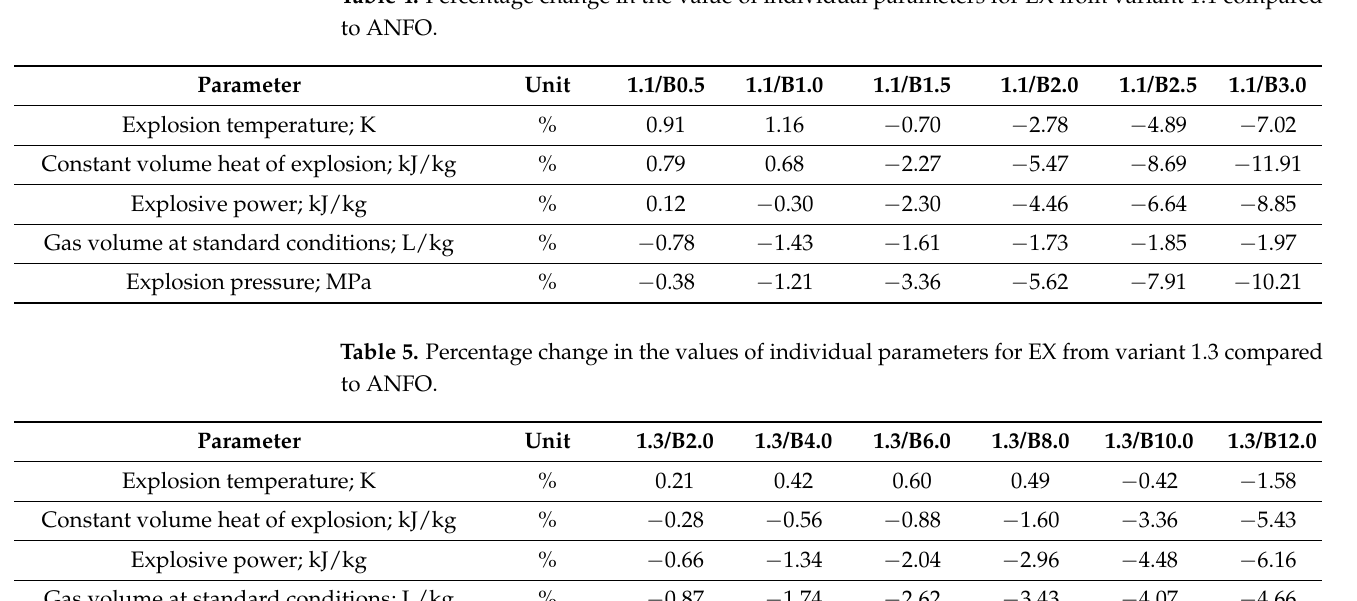
Table 4. Percentage change in the value of individual parameters for EX from variant 1.1 compared to ANFO.